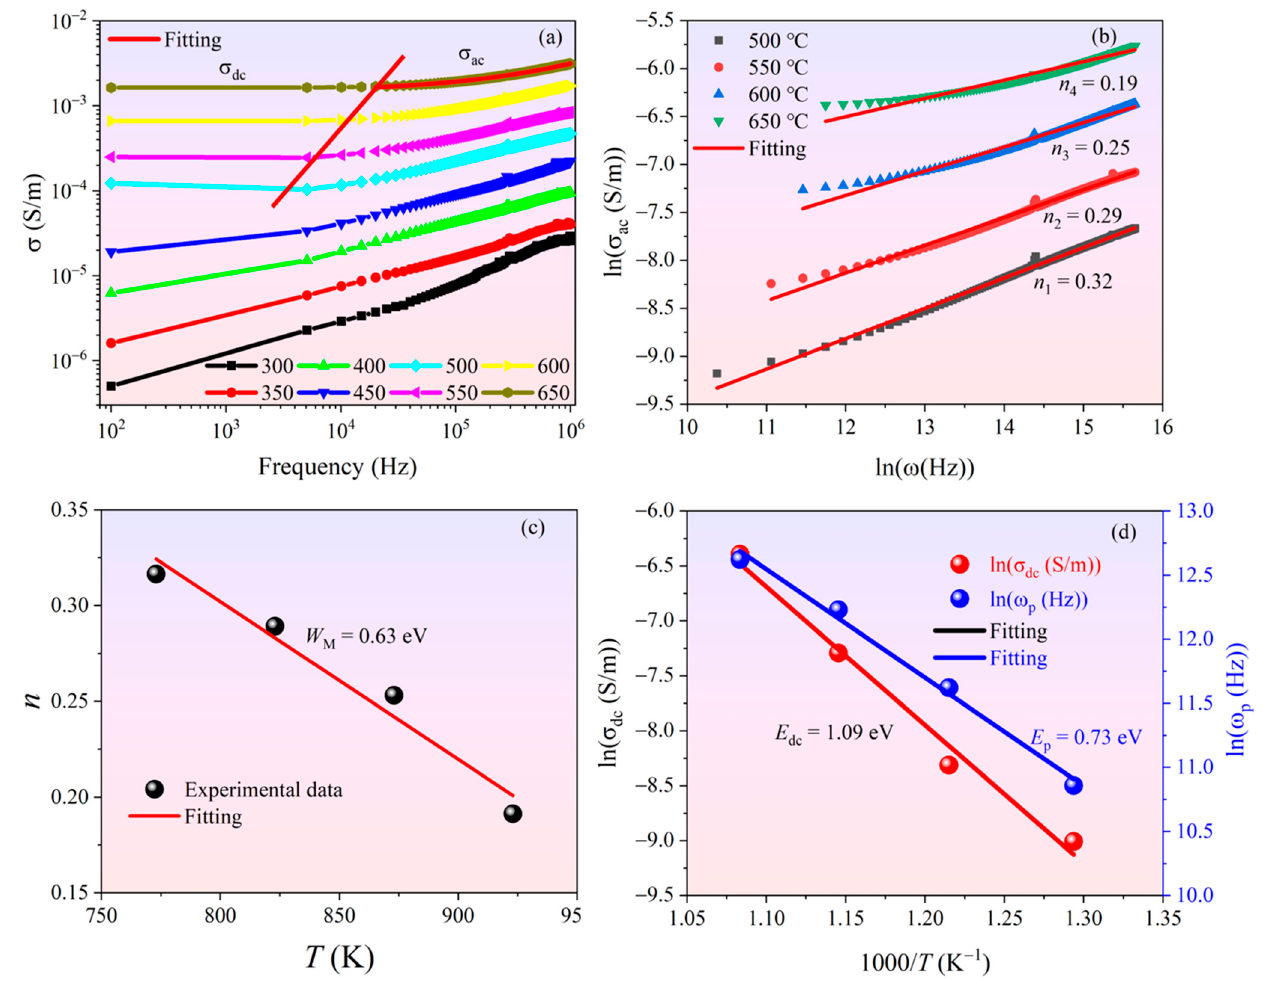
Figure 3. Electrical conduction spectroscopy of the BGTN − 0.2Cr ceramic at high temperature: ( a ) frequency dependence of the total conductivity; ( b ) relationship between ac conductivity and angular frequency; ( c ) values of the frequency index factor n calculated by the general Jonscher ’ s theory; ( d ) Arrhenius fitting of the plots of ln σ dc and ln ω p vs. 1000/ T .